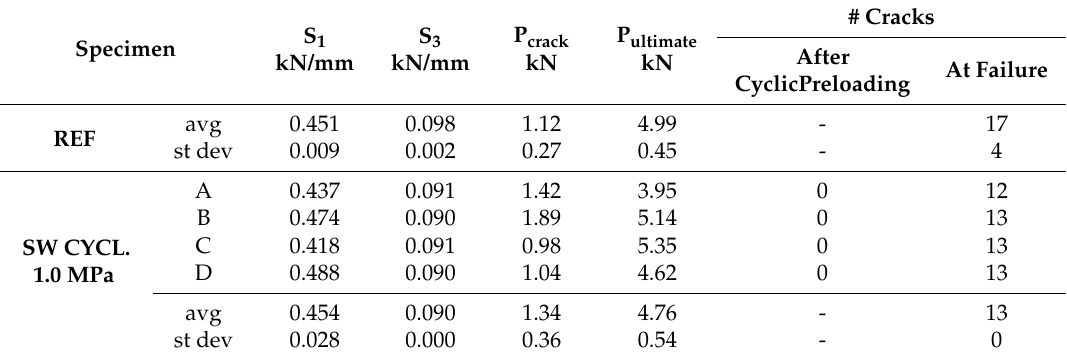
Figure 17. Residual behavior of SW CYCL. 1.0 MPa. Table 10. Quantitive comparison of some distinctive parameters of the static load-displacement curve: the average reference versus the beams cyclically preloaded to 1.0 MPa.